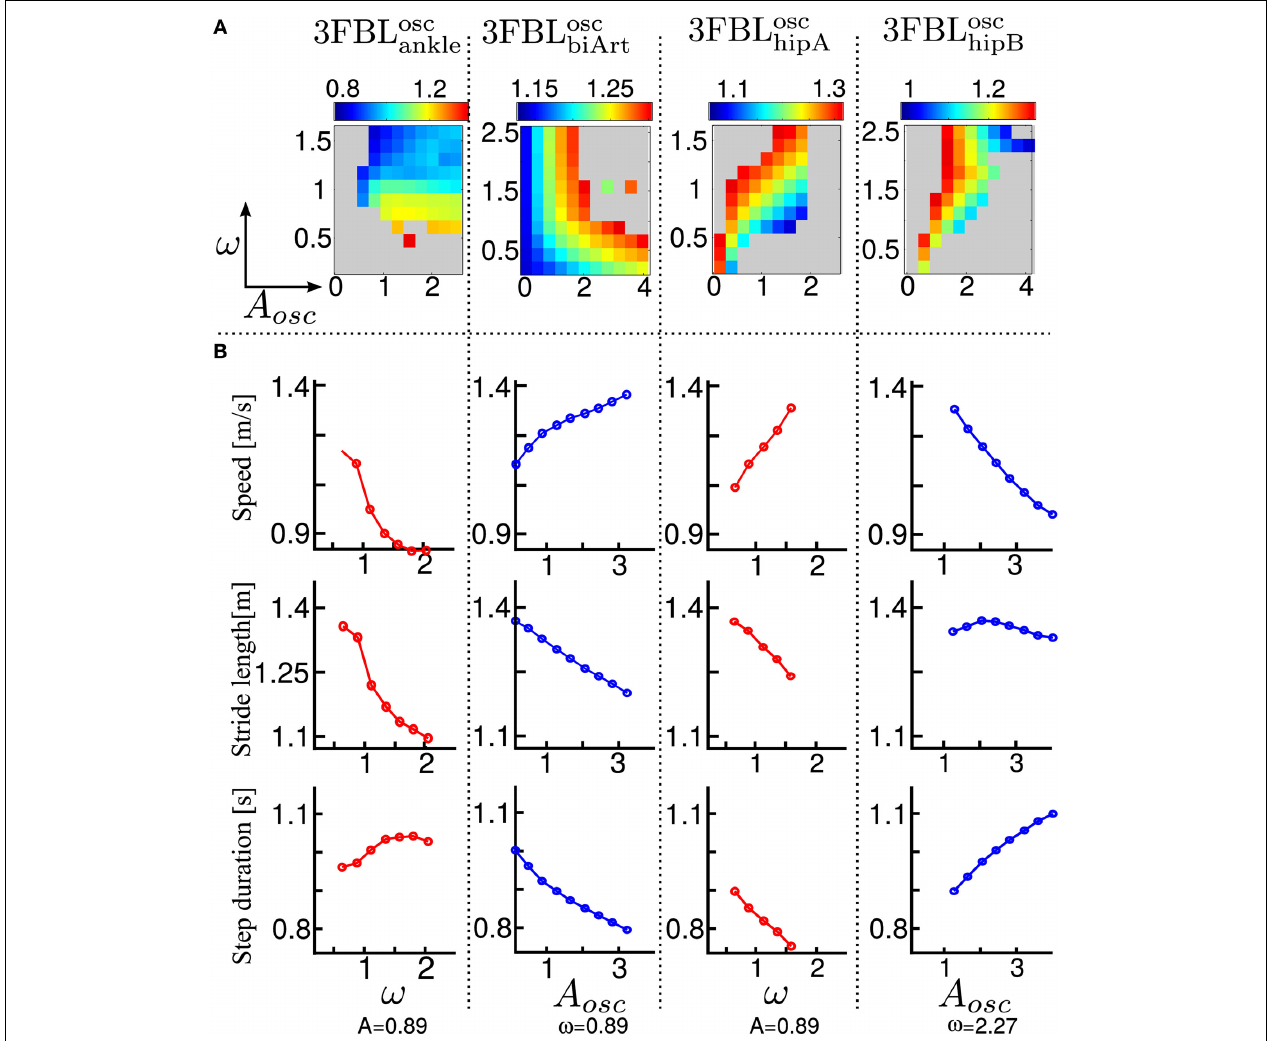
the gaits was unstable or asymmetric). (B) Highest variation in speed possible while maintaining one of the parameters constant (based on the heat map). A red/blue line means that ( μ osc / ω ) is kept constant, respectively. The value of the constant parameter is indicated at the bottom. The first row shows the speed, the second the stride length, and the third the step duration. Note that the 3FBL min fdb is not shown as its modulation is almost not